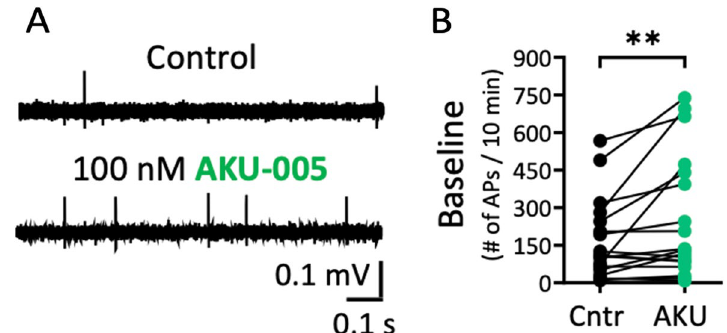
Fig. 3 Effect of dual MAGL‑FAAH inhibitor AKU‑005 on rat meningeal fibres. A Example traces of control basal and AKU‑005 (100 nM) induced activity in rat meningeal fibres. B Statistics show lightly increased general excitability in the presence of AKU‑005 as evidenced by an increasing number of APs for the 10‑min application window in the presence of AKU‑005 (AKU) ( N (Cntr) ( N 19, Wilcoxon test, ** 0.002) = =